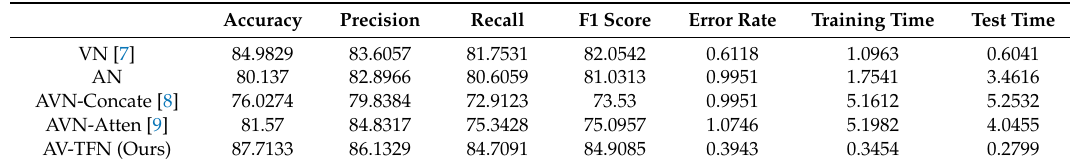
Table 3. Experiment results on comparison of AV-TFN with existing methods